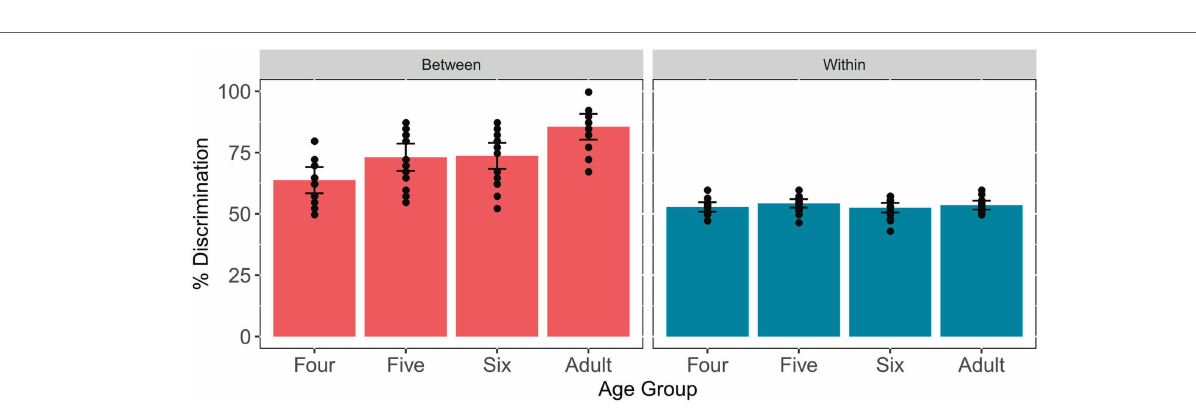
FIGURE 12 | Means and standard errors of the between- and within-category discrimination scores for the VOT continuum across age groups. Error bars: ±1 standard